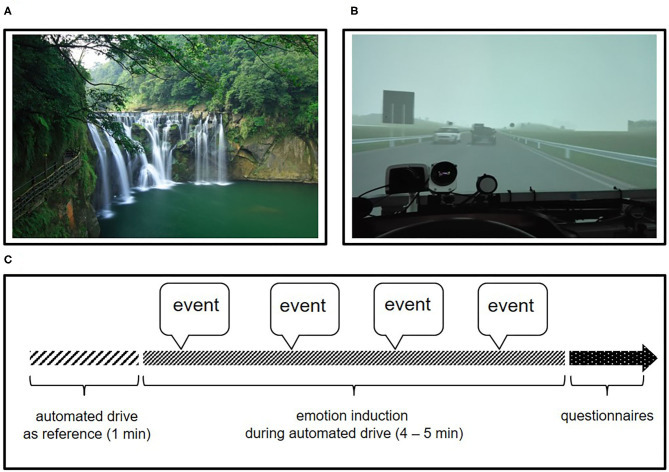
(A) Example for a relaxing image from the baseline scenario (Chiu, 2006); (B) View of participants while a vehicle swerving abruptly from the opposite lane during fear scenario; (C) Sketch of the procedure of each trial.